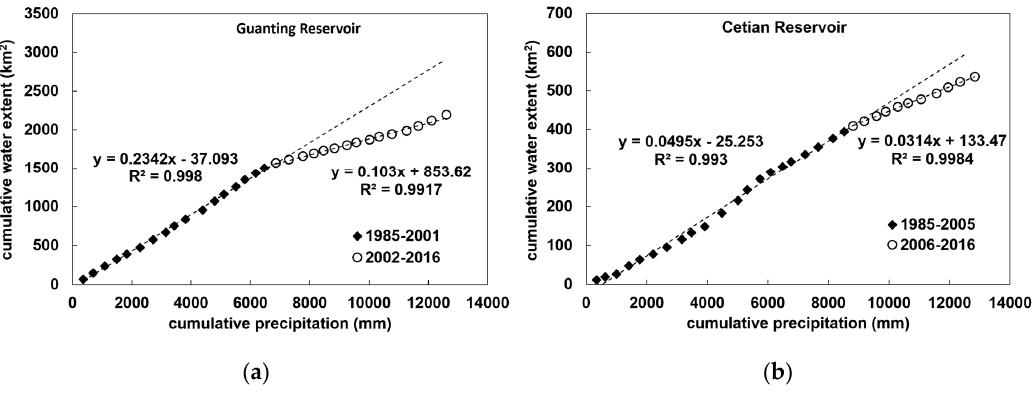
Figure 7. Double mass curve of cumulative annual water extents against cumulative precipitation for ( a ) Guanting reservoir and ( b ) Cetian reservoir. Table 4. Temporal variation of the relative contributions of climate variability and human interventions to annual water extents in Guanting and Cetian reservoirs.